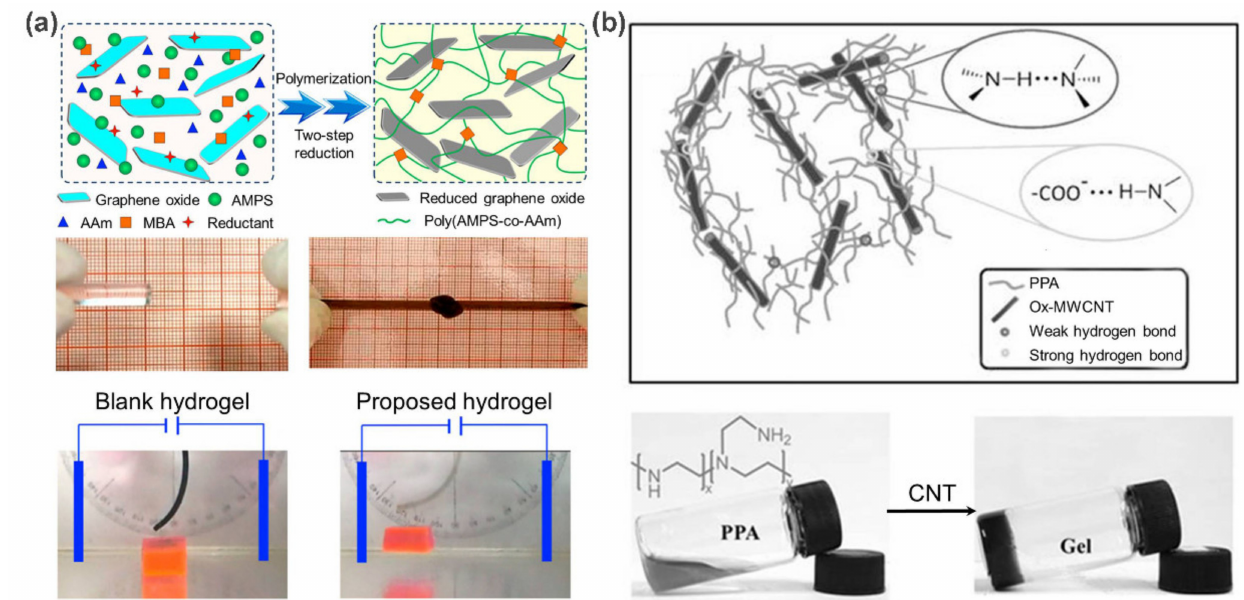
Figure 1. ( a ) Schematic representation of the fabrication of rGO/poly(AMPS- co -AAm) nanocomposite hydrogels. Pho- tographs show their improved mechanical properties and obvious electro-responsive bending behaviors. ( b ) The formation of ox-MWCNTs/PPA hydrogels via hierarchical hydrogen bonds. Adapted with permission from Refs.